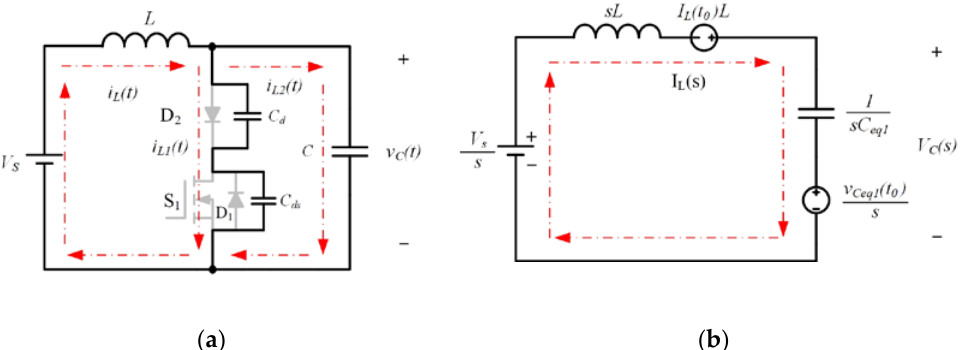
Figure 4. Mode 1 principle: ( a ) the equivalent circuit; ( b ) the Laplace transform circuit. Appl. Sci. 2020 , 10 , x FOR PEER REVIEW